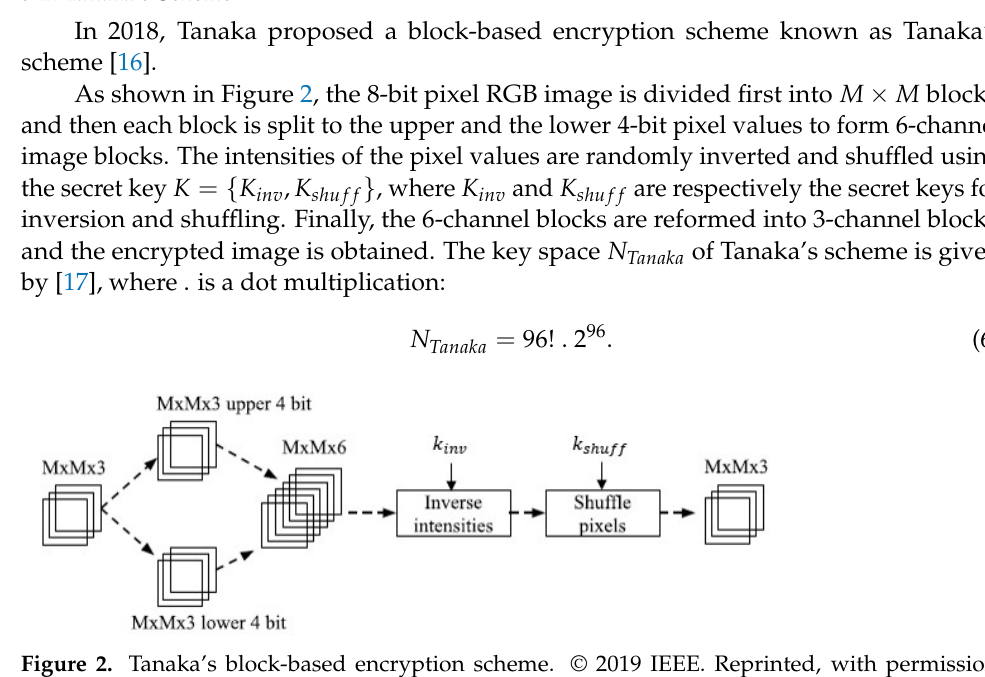
Figure 2. Tanaka’s block-based encryption scheme. © 2019 IEEE. Reprinted, with permission, from